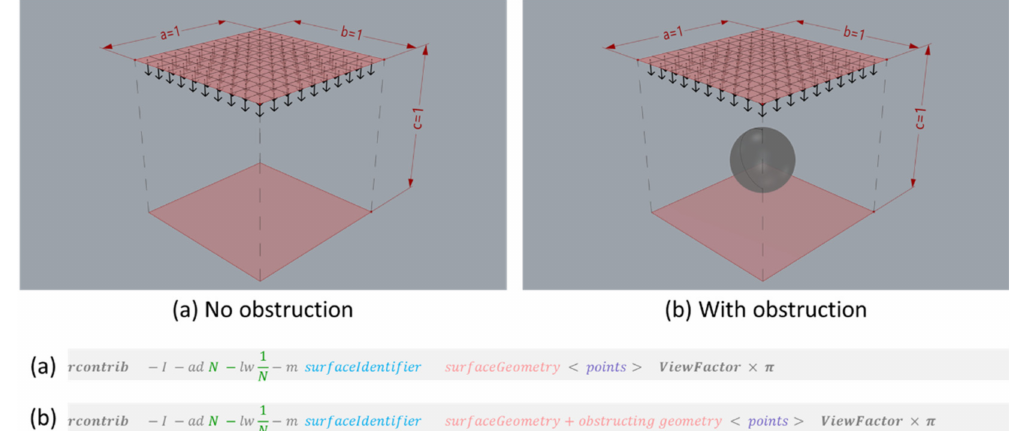
Figure 16. A comparison of the geometric setup and corresponding command-line arguments for view factor calculations without obstruction ( a ) and with obstruction ( b ). In ( b ), the additional sphere constitutes the obstruction.